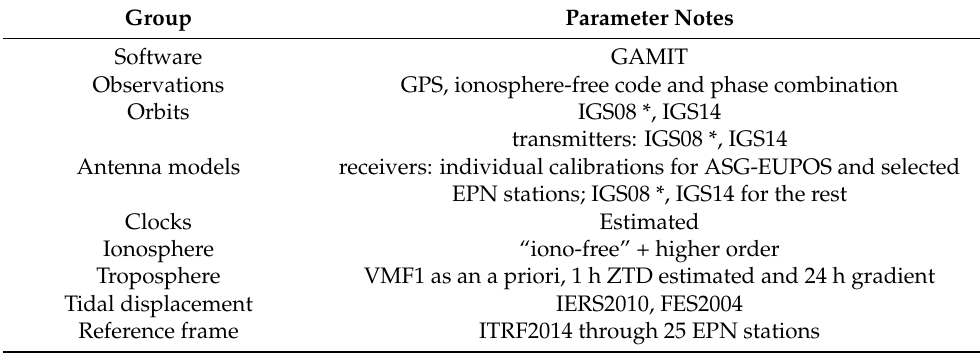
Table 1. Summary of the processing parameters.